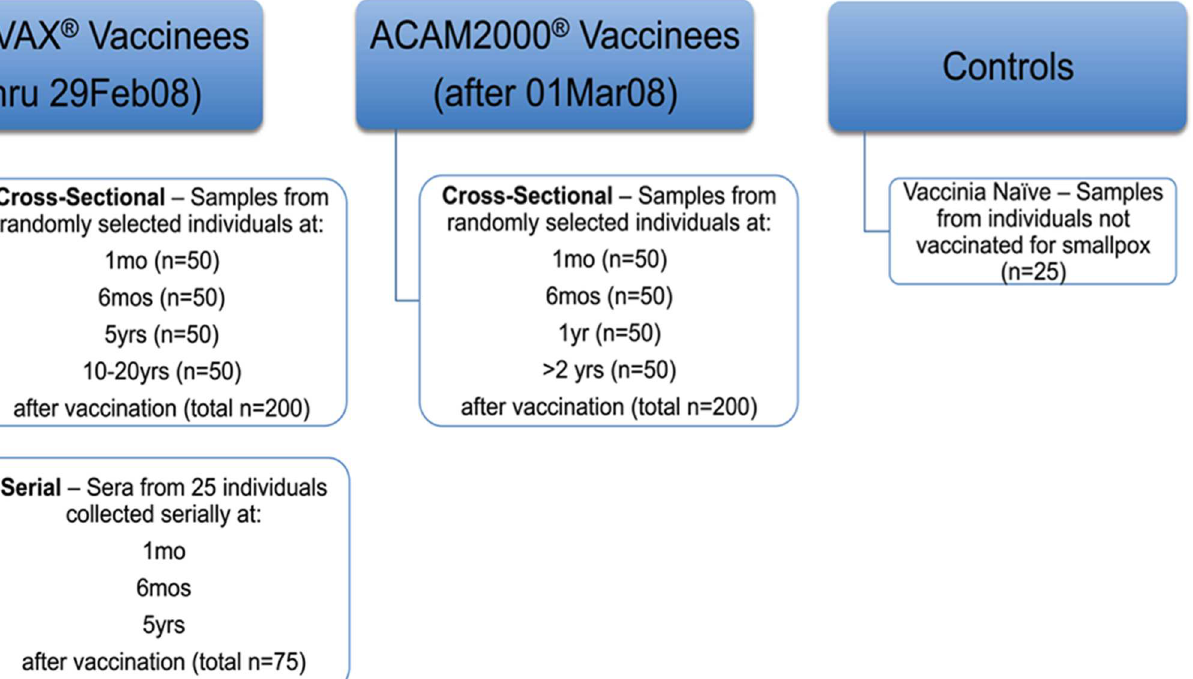
PLOS ONE | DOI:10.1371/journal.pone.0169247 January3,